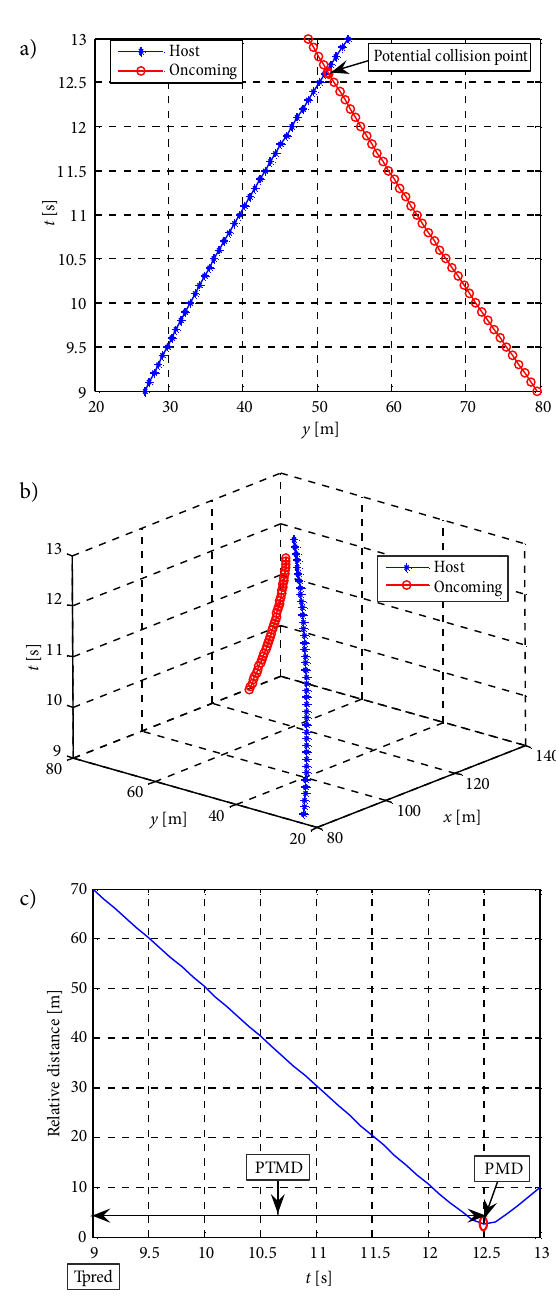
Fig. 3. Collision detection: a – change in position along y -axis with time, b – change in position with time; c – change in relative distance with